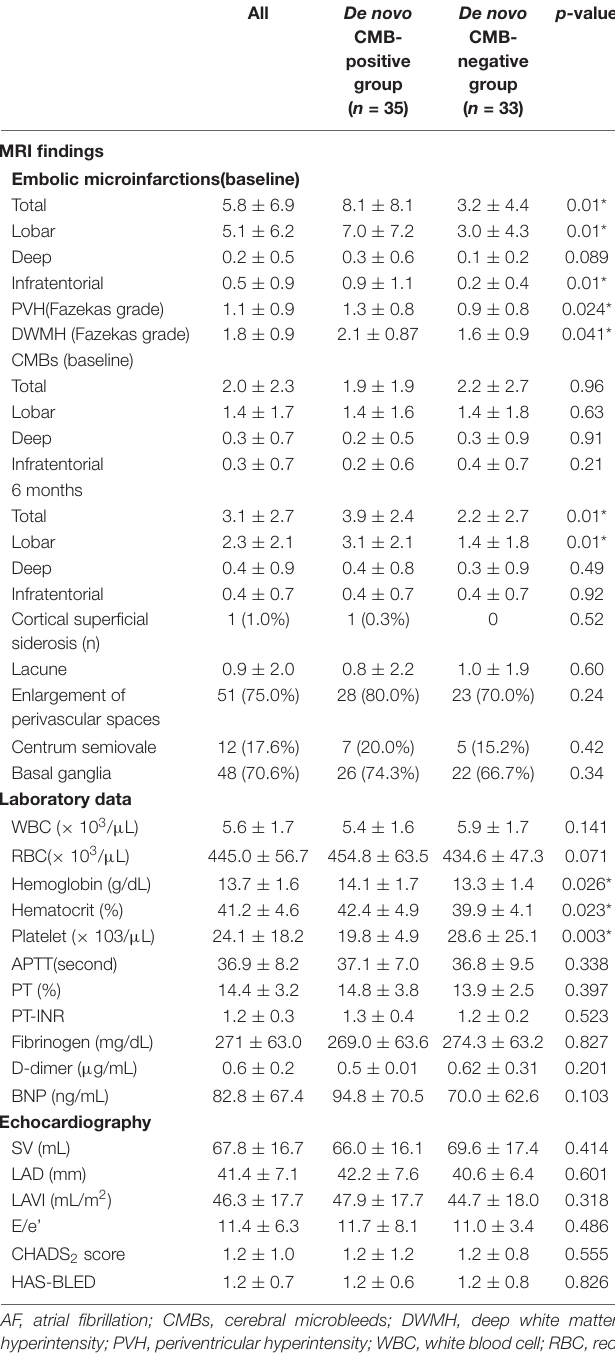
TABLE 3 | MRI findings, laboratory, and echocardiography findings in the 68 patients with AF. All De novo